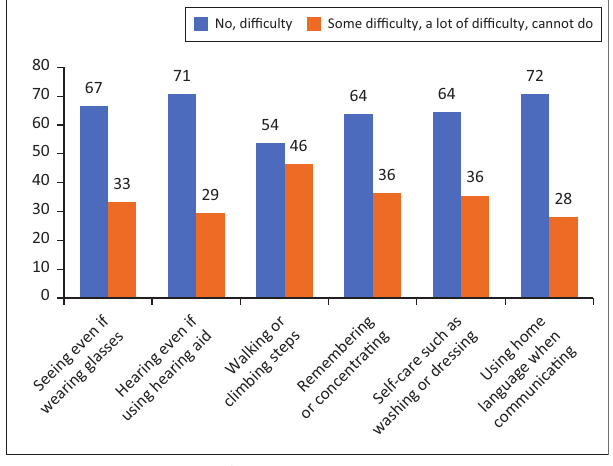
FIGURE 1: Washington group short set questions: Numbers indicating difficulties within six domains ( N =